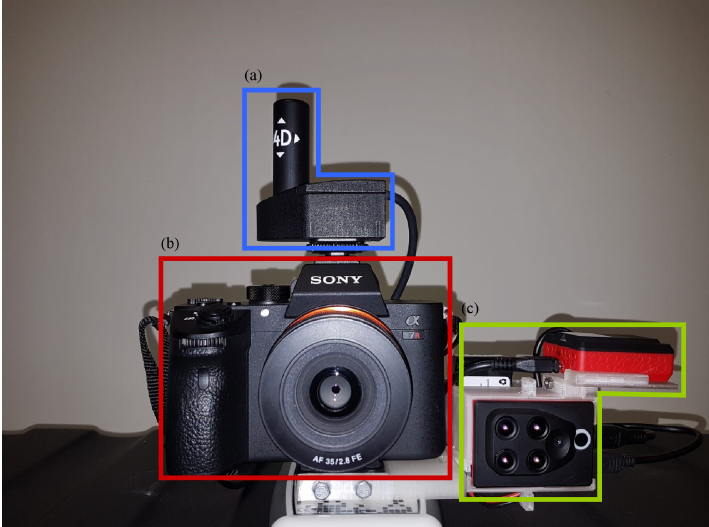
Figure 3. The acquisition system. ( a ) the IMU and GPS, ( b ) the high-resolution camera; and ( c ) the multispectral